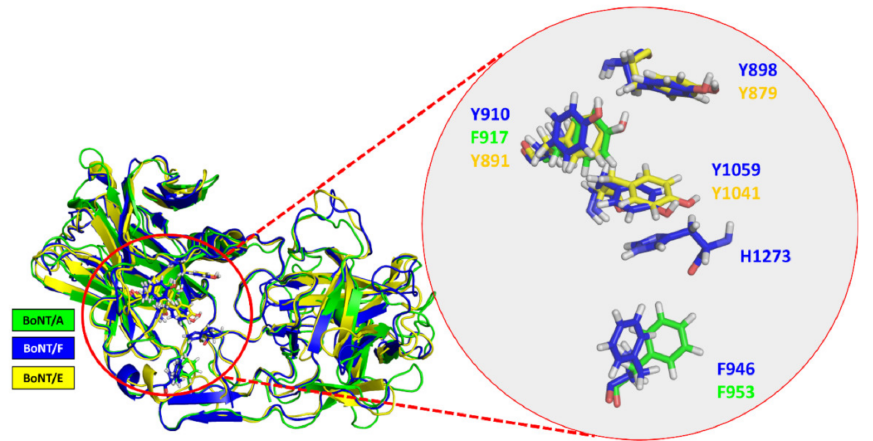
Figure 7. Structural alignment of BoNT/A1 and BoNT/E1 with the structure of BoNT/F1 and focus on the aromatic residues that interact with glycan. BoNT/A1 is depicted as the color green; BoNT/F1 and BoNT/E1 are colored in blue and yellow, respectively.